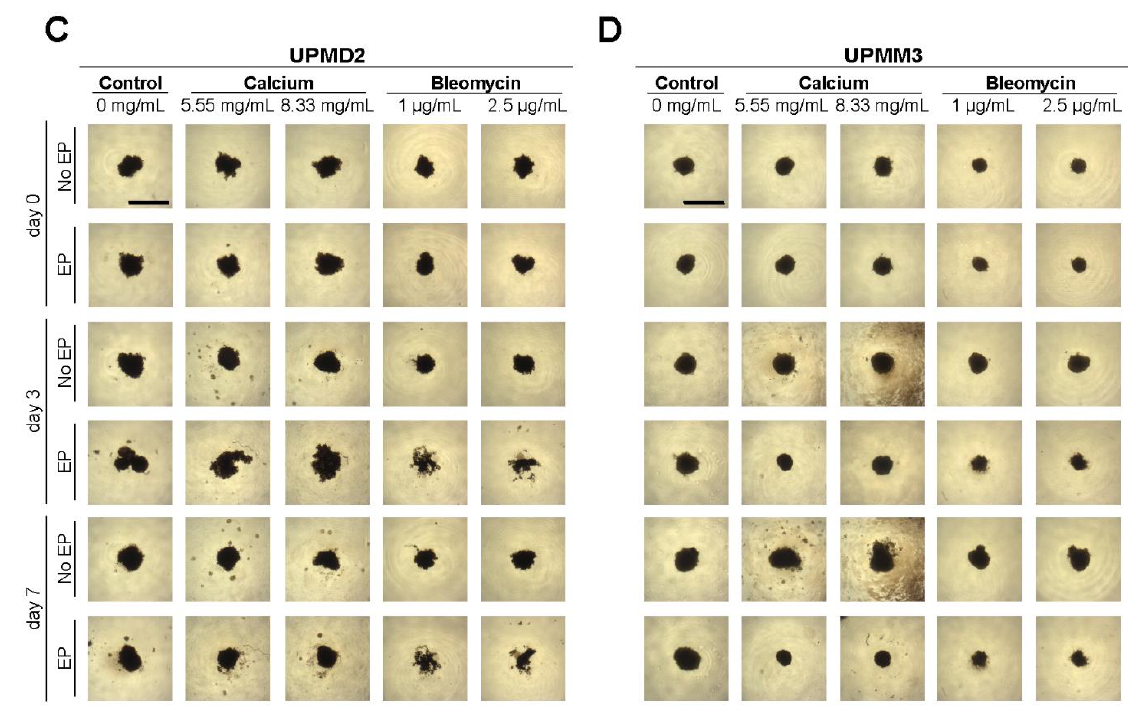
Figure 4. UM and UPM spheroids after EP with calcium chloride and bleomycin. Image documen- tation of ( A ) UM92.1, ( B ) Mel270, ( C ) UPMD2, and ( D ) UPMM3 spheroids was conducted before (day 0) and on days 3 and 7 after electroporation (EP) in combination with calcium chloride (5.55 or 8.33 mg/mL) or bleomycin (1 or 2.5 μg/mL). Untreated cells, calcium chloride alone, bleomycin alone (no EP group), or EP alone constitute the control groups. Images were recorded at 4 × magnification;